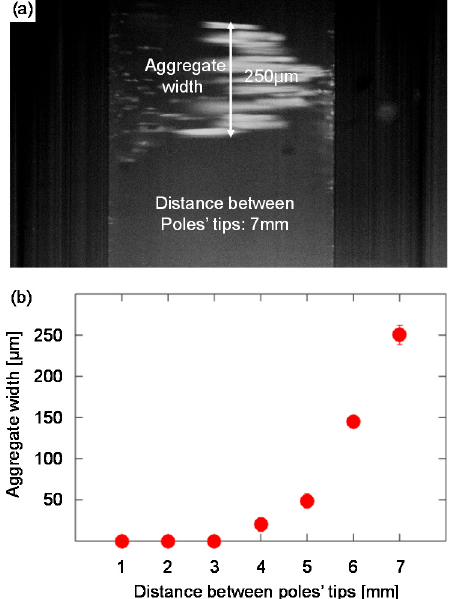
Figure 8. The correlation between the width of the aggregate and the distance between the pole tips. ( a ) The width of the beads’ aggregate when manipulated by two electromagnets with parabolic pole tips ( 𝛽 = 0.65 ) that are positioned 7 mm opposite each other (the cuvette’s width is 0.6 mm). ( b ) Experimental measurements of the width of the aggregate as a function of the distance between the pole tips.